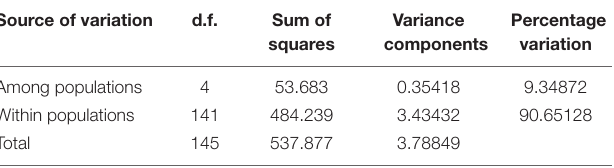
Variance Percentage squares components variation